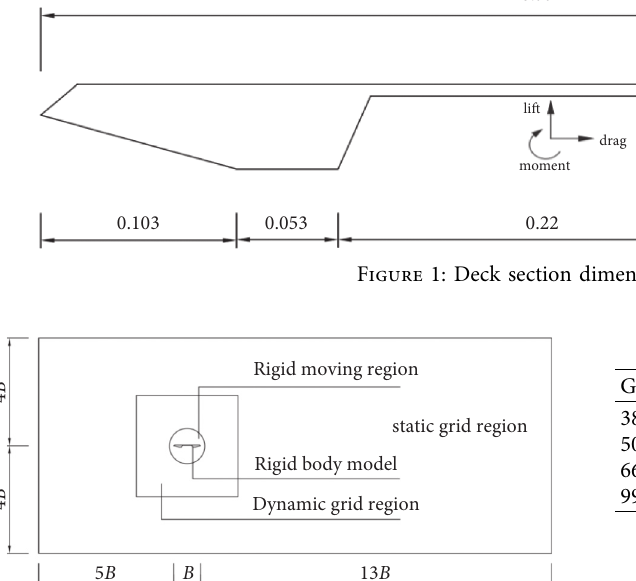
Table 2: Time-step independence